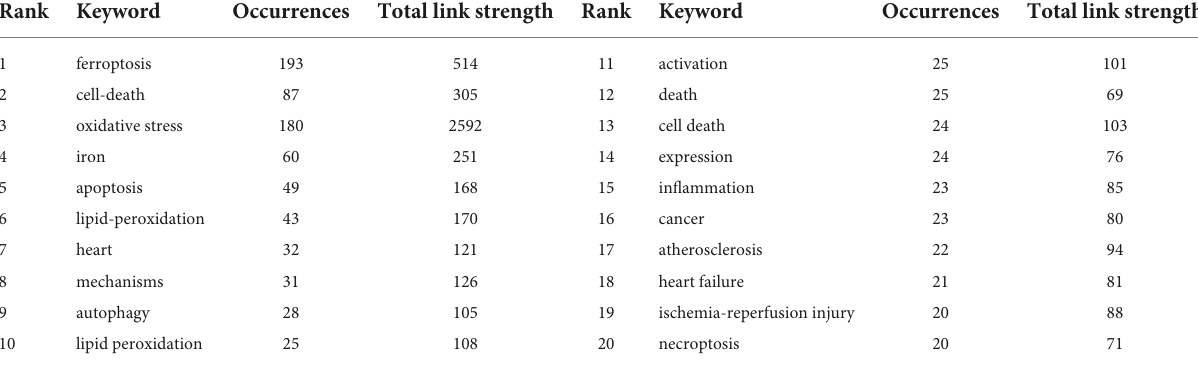
TABLE 7 Summary of the top 20 keywords related to ferroptosis in cardiovascular